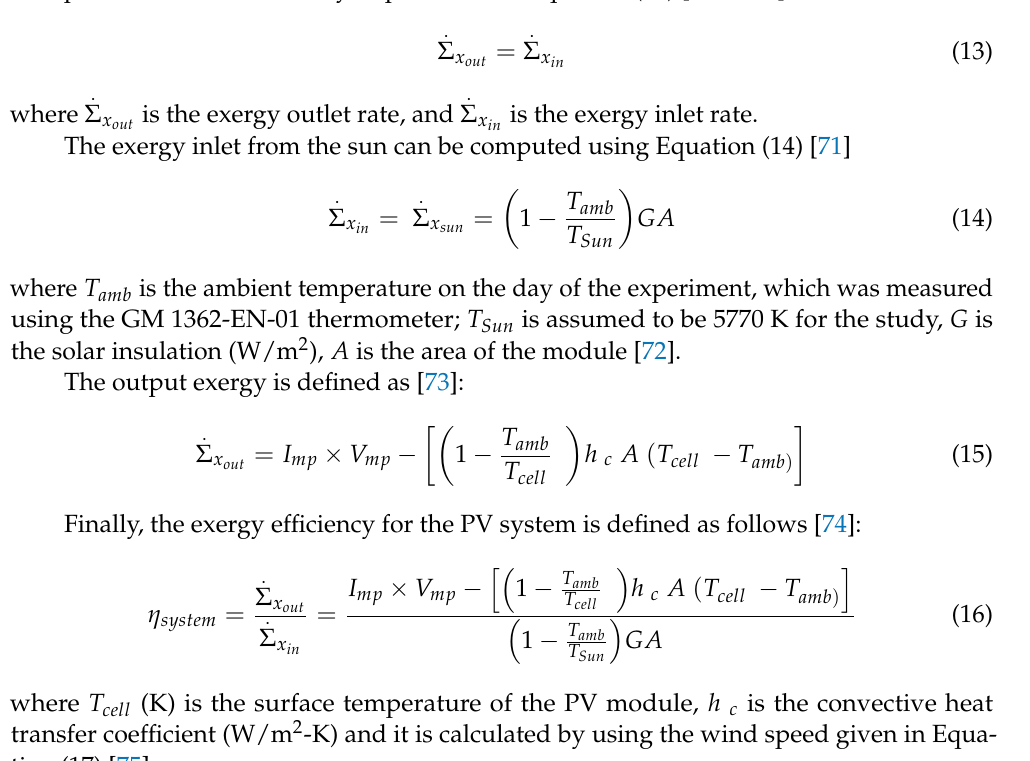
Figure 6. Effect of incident radiation on the P-V plot at 45 °C cell temperature (obtained from PVsyst software).